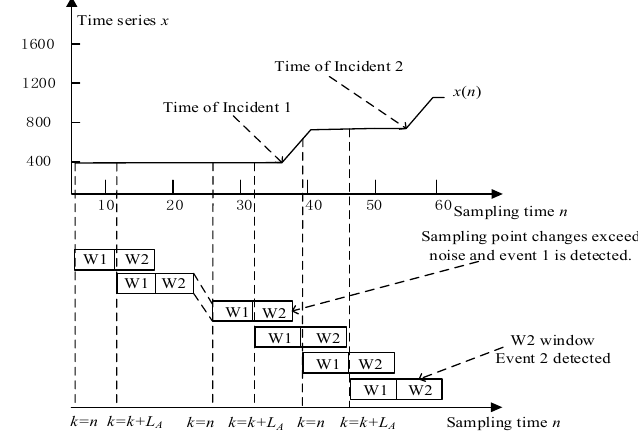
Figure 1. The method